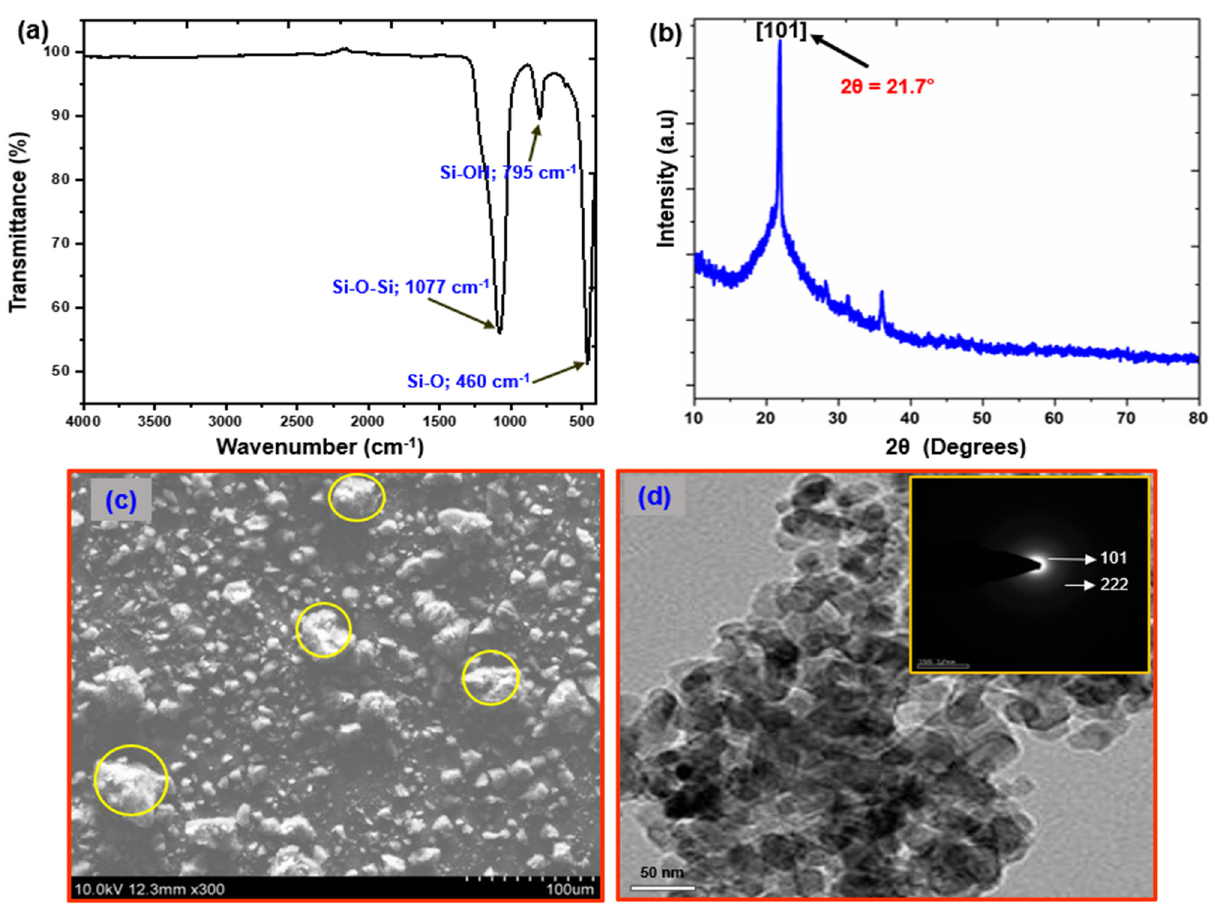
Figure 2. Structural and morphological characterization of SiO 2 nanoparticles: ( a ) FTIR spectrum; ( b ) XRD pattern; ( c ) SEM; and ( d ) TEM images (inset in d is the SAED pattern).